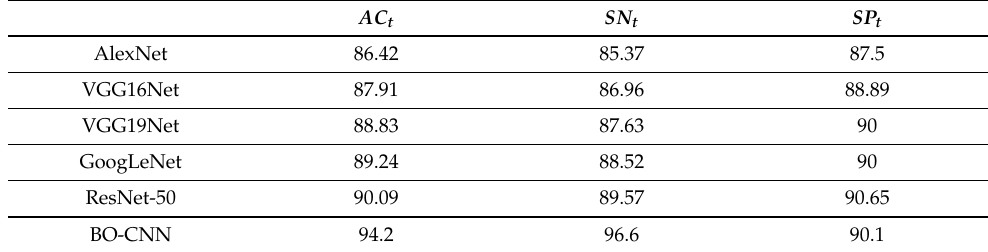
Table 6. Proposed BO-CNN model vs. pre-trained-CNN models for the IDRiD